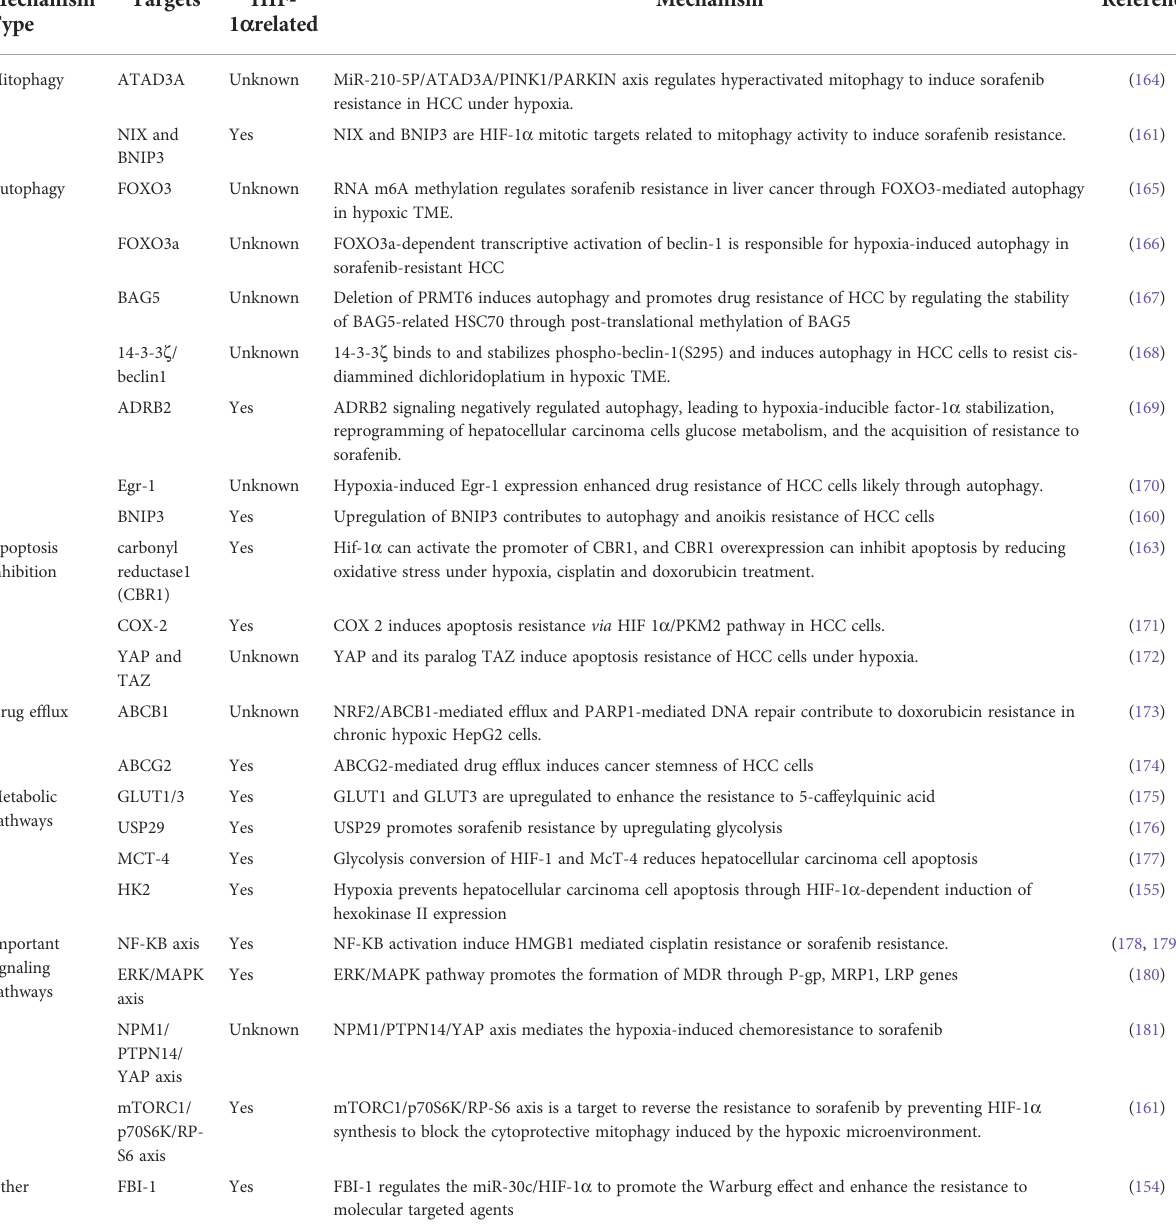
TABLE 3 hypoxia related gene targets and mechanisms induced chemotherapy resistance in HCC. Mechanism